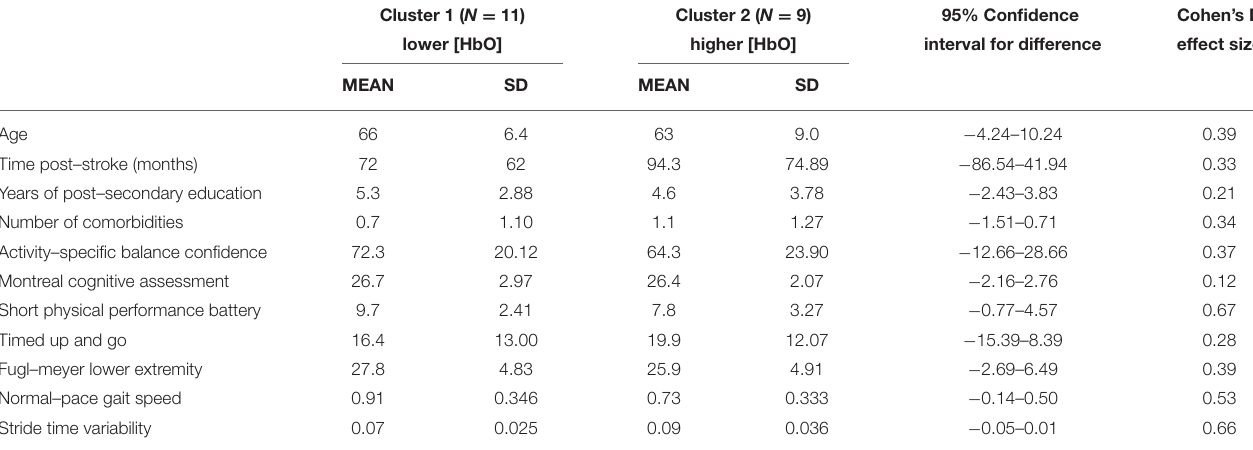
TABLE 4 | Demographic and clinical outcome averages split between HbO clusters.